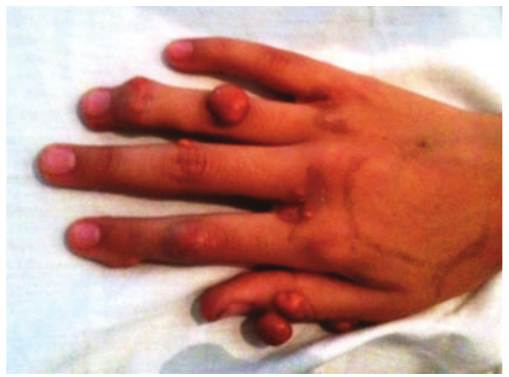
Figure 2: Cutaneous xanthomas on the hand of patient no. 2.